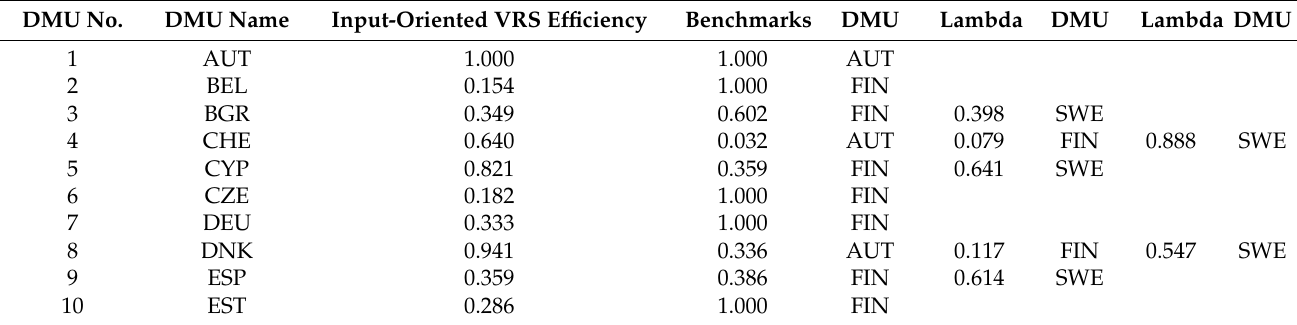
Table 4. Input-Oriented VRS Efficiency of EPS in 2015. Source: Authors’ calculations in DEAFrontier. DMU